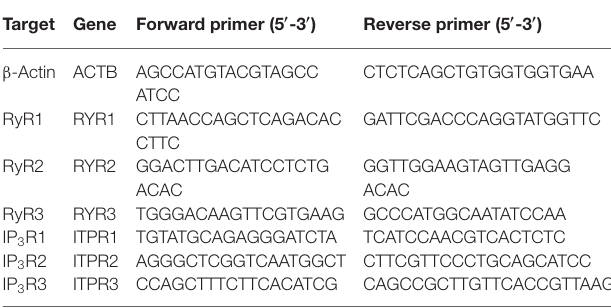
TABLE 1 | A list of primers used for quantitative real-time PCR analysis. Target Gene Forward primer (5 (cid:48) -3 (cid:48)